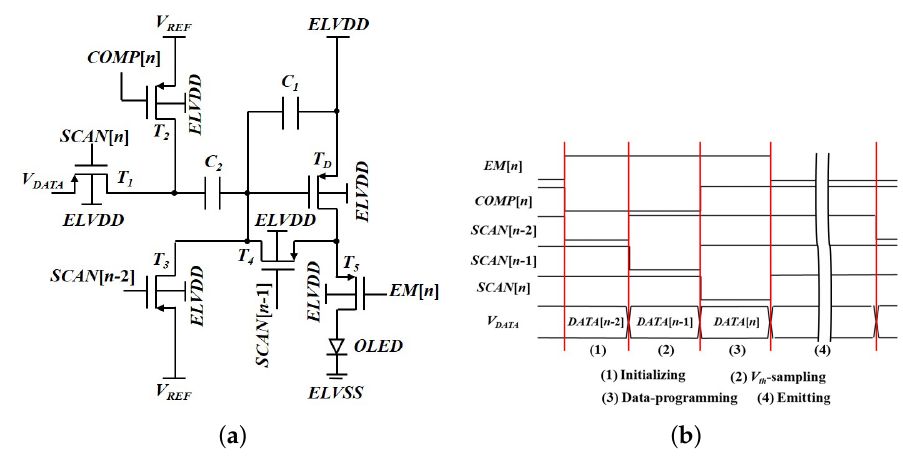
Figure 1. Proposed OLEDoS pixel circuit. ( a ) Schematic. ( b ) Timing diagram.